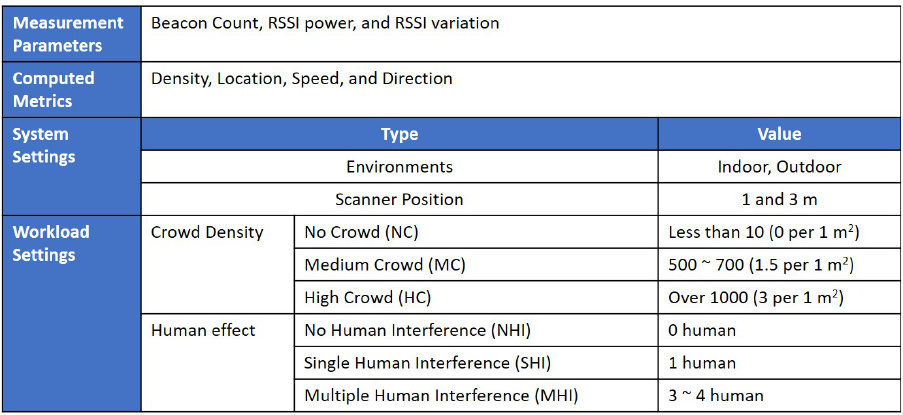
Figure 14. Experimental Settings.